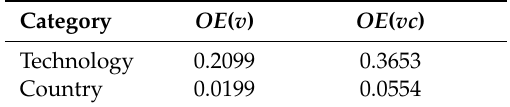
Table 11. The p -value of the rank sum test on input-based e ffi ciencies.